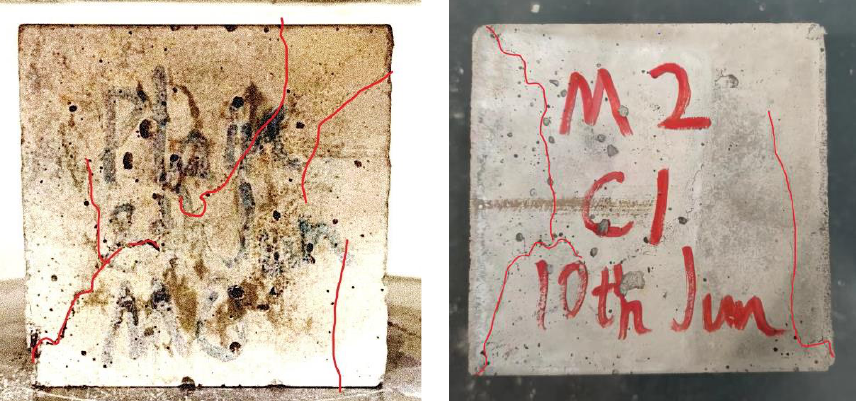
Figure 3. Cracks of the specimen after the compression test by contrast. (Left is cube of M0, and right is cube of M2)